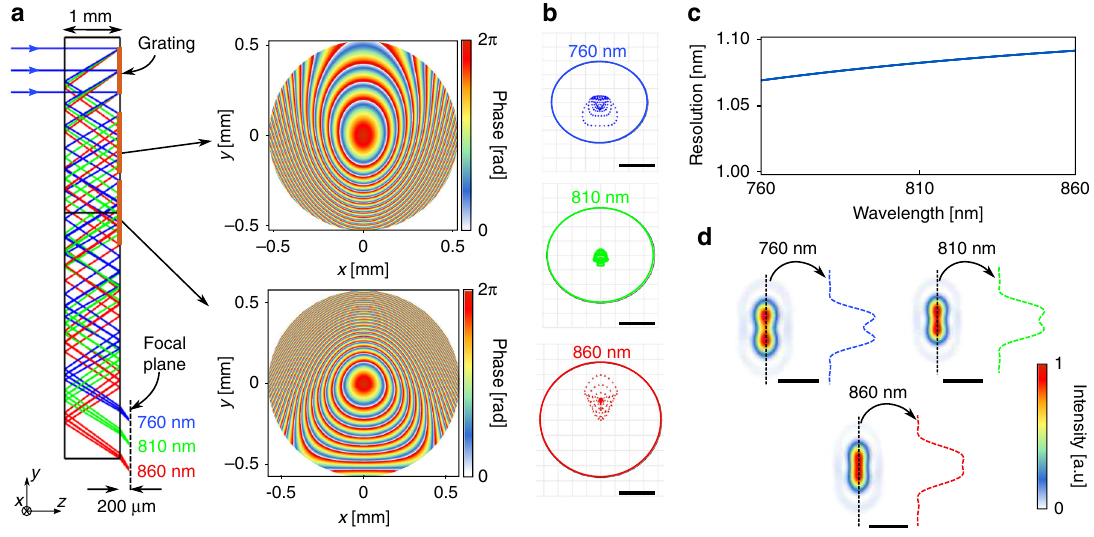
Fig. 2 Ray-optics design and simulation results of the folded spectrometer. a Ray-tracing simulation results of the folded spectrometer, shown at three wavelengths in the center and two ends of the band. The system consists of a blazed grating that disperses light to different angles, followed by two metasurfaces optimized to focus light for various angles (corresponding to different input wavelengths). The grating has a period of 1 μ m, and the optimized phase pro fi les for the two metasurfaces are shown on the right. b Simulated spot diagrams for three wavelengths: center and the two ends of the band. The scale bars are 5 μ m. c Spectral resolution of the spectrometer, which is calculated from simulated Airy disk radii and the lateral displacement of the focus with wavelength. d Simulated intensity distribution for two wavelengths separated by 1.1 nm around three different center wavelengths of 760, 810, and 860 nm. The intensity distributions show that wavelengths separated by 1.1 nm are theoretically resolvable. The scale bars are 20 μ